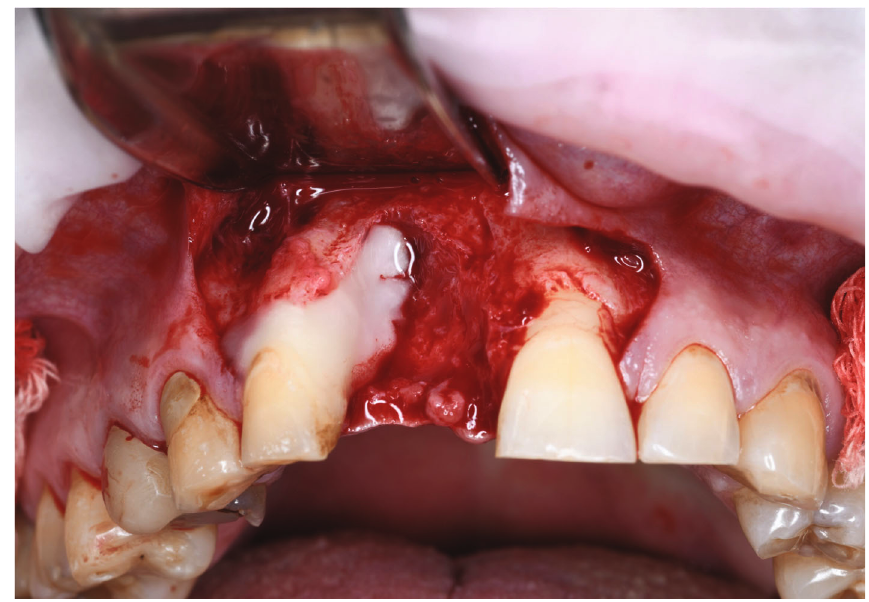
Figure 6: Root conditioning with ethylenediaminetetraacetic acid and enamel matrix derivative